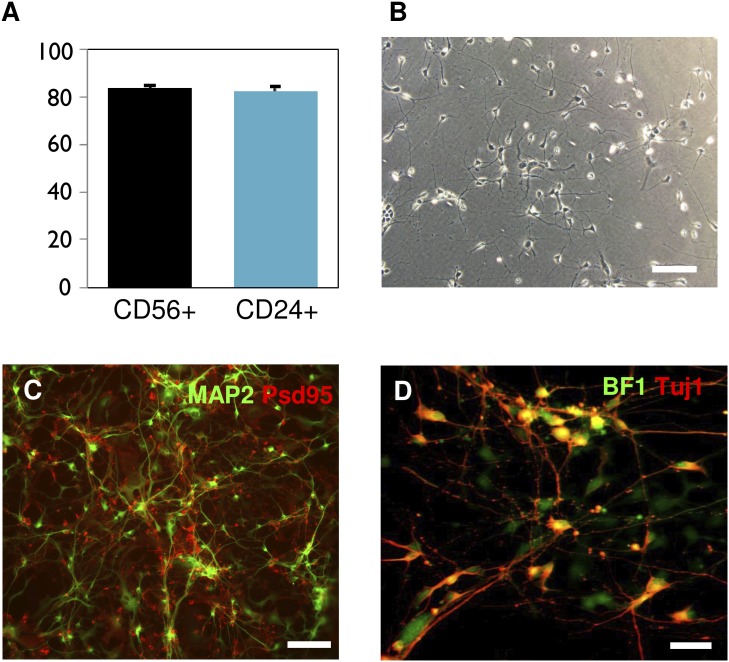
Flow cytometry and immunofluorescence analyses of iPSC-derived neurons.A) Flow cytometry analysis of neuronal surface markers CD56 and CD24 at day 32 of differentiation. B) Representative phase contrast microscope image of cultured neurons at day 32 of differentiation. Scale bar: 100 µm. C) At day 45 of differentiation, cells express MAP2 (green) along soma and dendrites and the postsynaptic protein PSD95 (red), confirming the advanced stage of differentiation into neurons. Scale bar: 100 µm. D) Cells also express the forebrain-specific marker BF1 (green) and Tuj1 (red) at 45 days of culture. They are often co-localized (yellow). Scale bar: 50 µm.